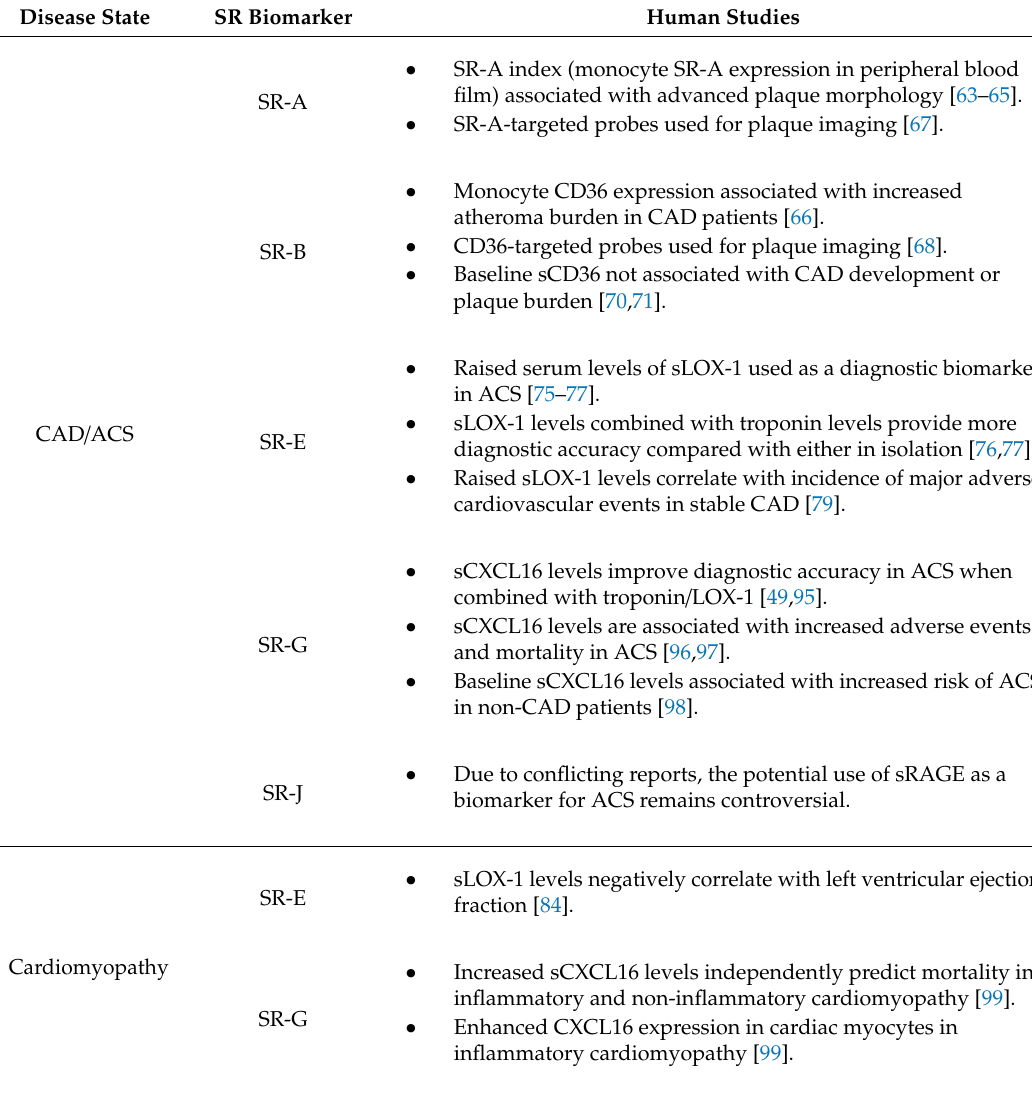
Table 2. SRs as biomarkers in